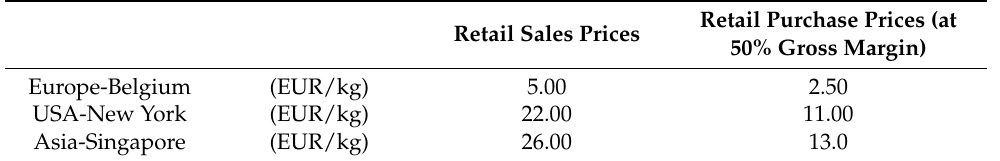
Table 4. Retail sales prices and retail purchase prices at 50% gross margin for Romaine lettuce [18]. Retail Sales